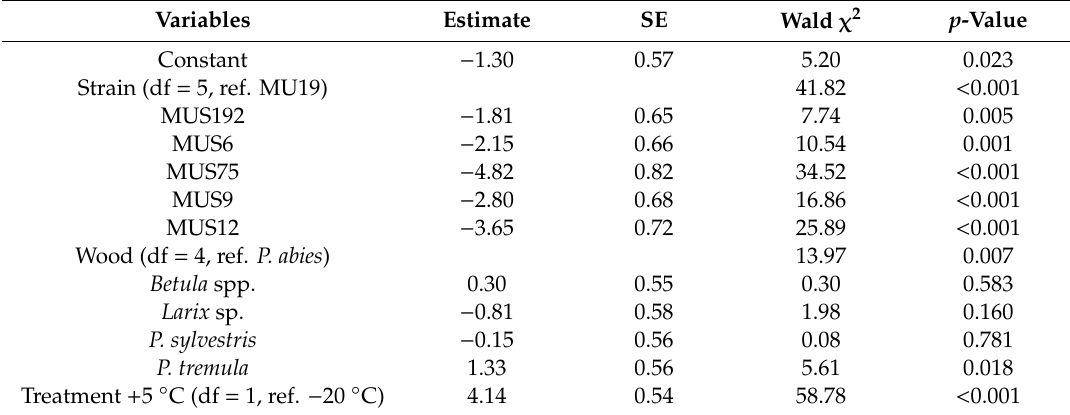
Table 1. The parameter estimates, their standard errors (SE) and Wald χ 2 tests for the terms in the logistic regression model (Equation (1)) for the probability of the successful fruiting of G. lucidum . p -values are calculated for the variables in the model based on Wald’s chi-square statistics.